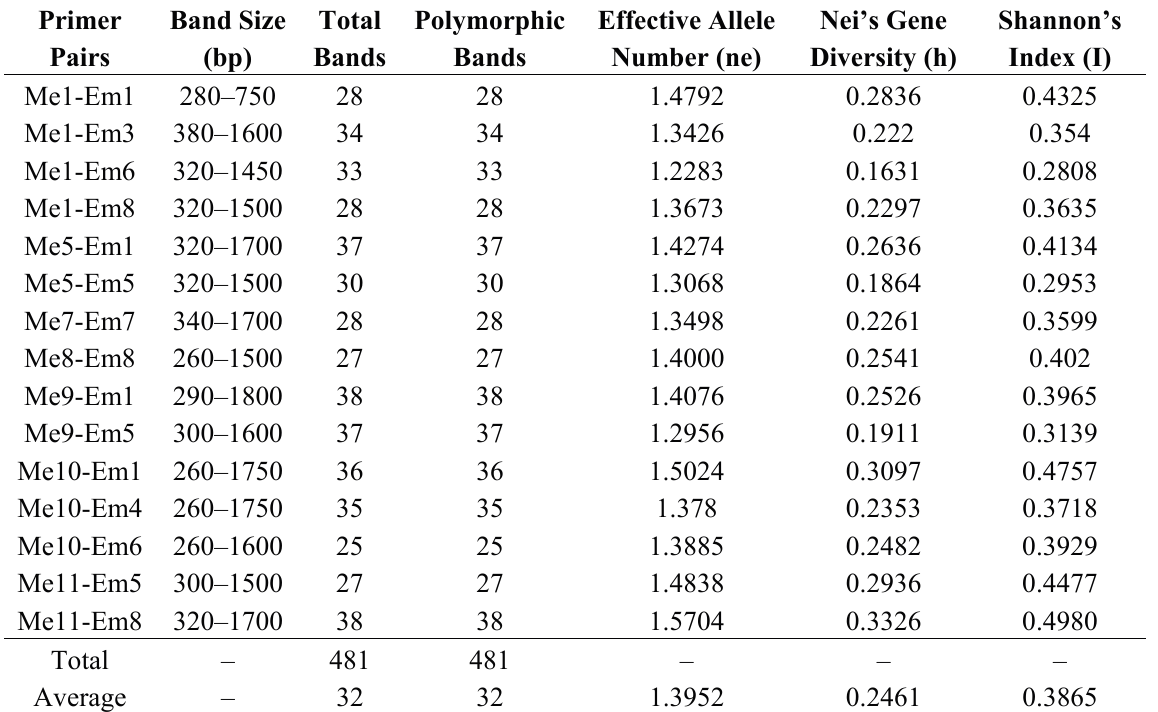
Table 1. Polymorphisms detected by 15 sequence-related amplified polymorphism